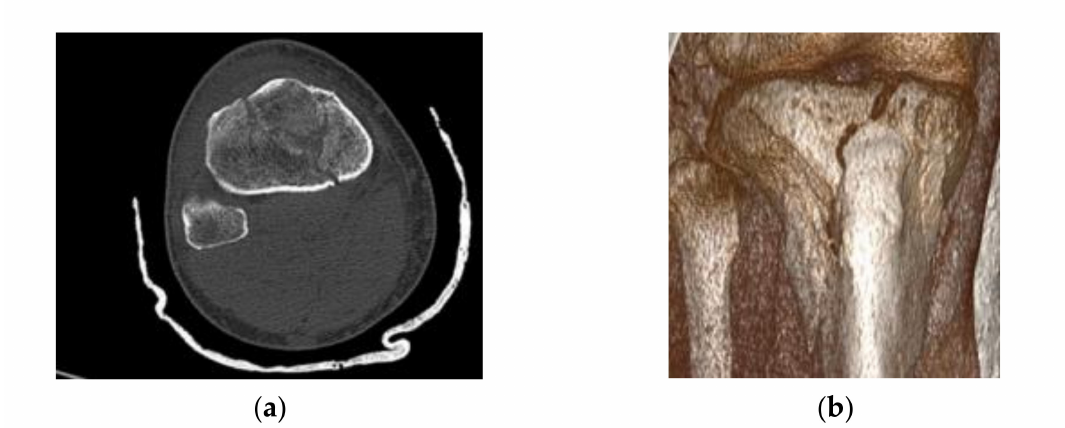
Figure 8. ( a ) Digital Imaging and Communications in Medicine (DICOM) image; and ( b ) RadiAnt DICOM image of the patient included in the study.